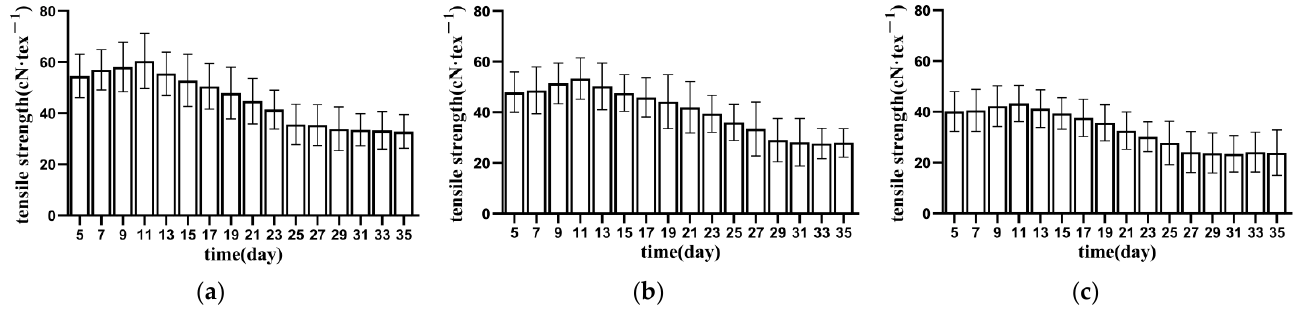
Figure 4. Tensile strength of middle banana stem fibres. ( a ) B Ⅰ ; ( b ) B Ⅱ ; ( c ) B Ⅲ .